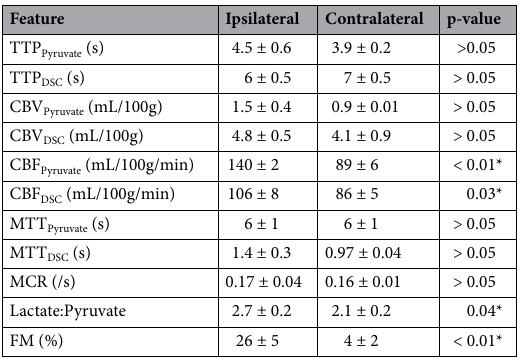
Table 1. Results from ROI analysis from the rodent model of stroke. * Statistically significant.